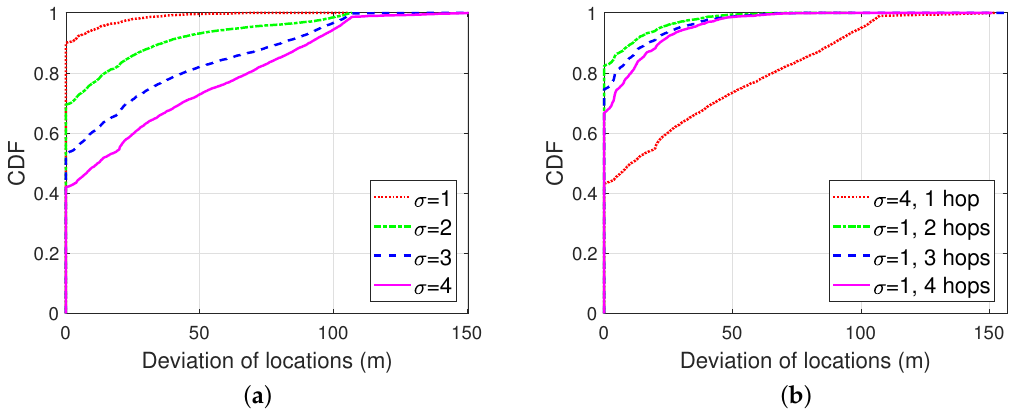
Figure 10. CDF of deviation of retrieved locations: ( a ) with different noises; ( b ) with different number of assistant neighbors.